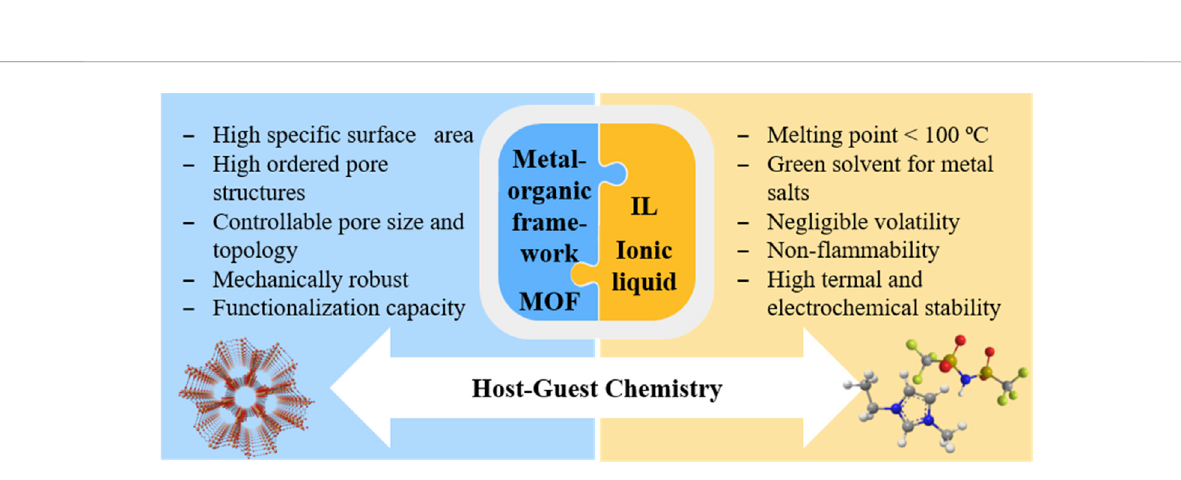
FIGURE 3 Overview of the fundamental properties that MOFs and ILs present for their integration as components of IL@MOF hybrid electrolytes.